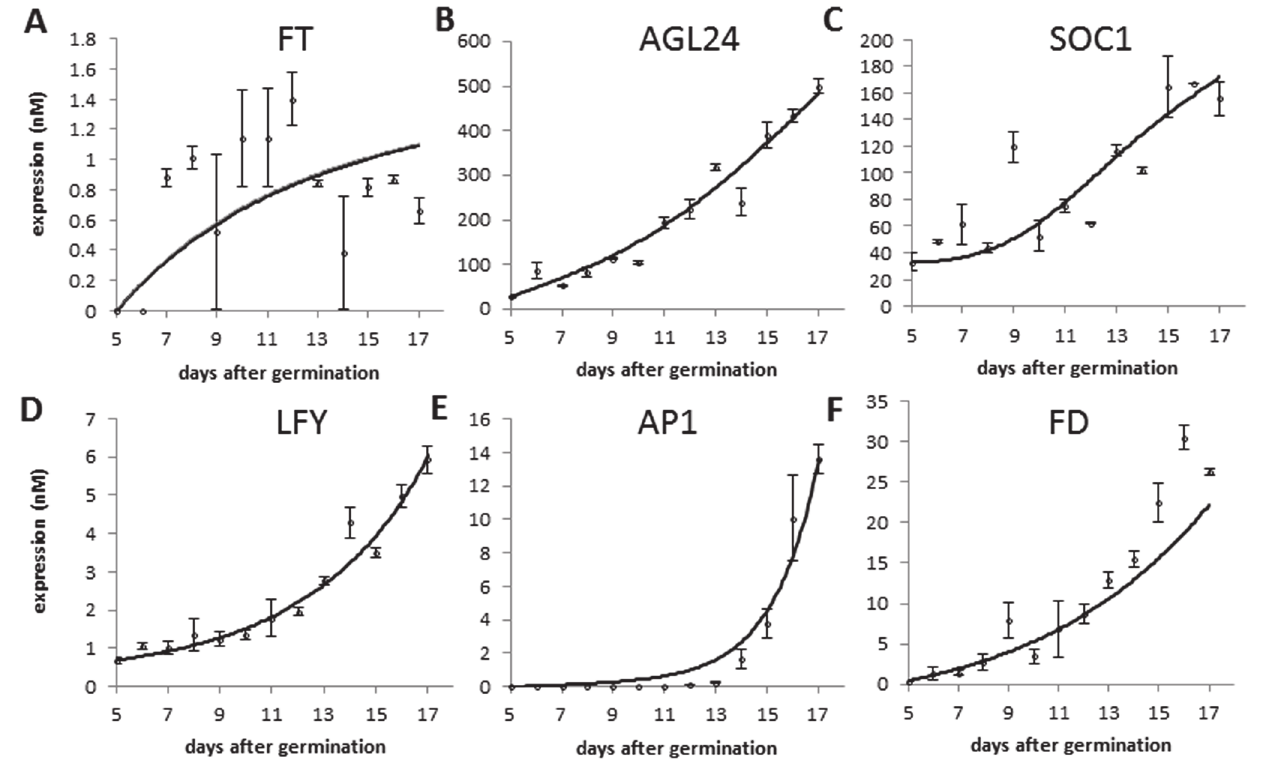
Fig 2. Experimental and simulated expression time-course of the genes in the integration network model. Gene expression was measured by qRT- PCR (shown as dots) of wild type plants grown under long-day conditions at 23°C (average and standard deviation are shown). The continuous lines show the simulated gene expression using the parameters estimated by data fitting. Note that FLC and SVP are not regulated by other components of the network and hence are present as input factors only, and their expression level is not simulated by the model. qRT-PCR data for FT was obtained from leaves; for the other genes, qRT-PCR data was obtained from meristem enriched